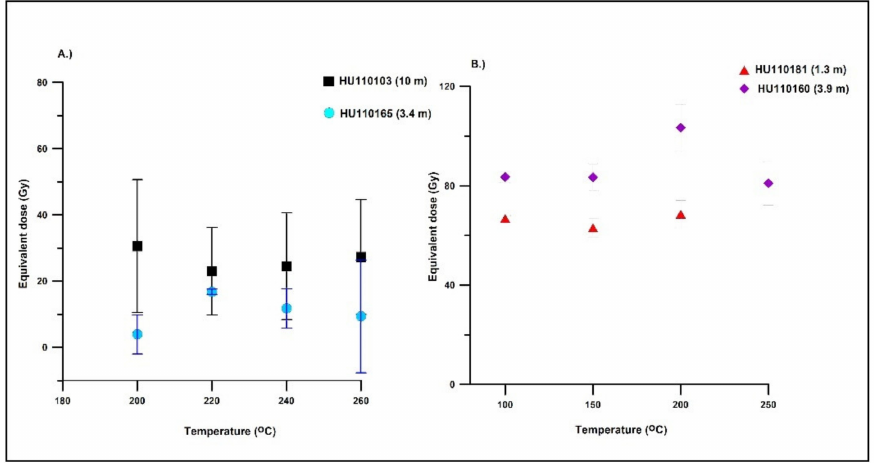
Figure 5. Results of preheat plateau tests for selected quartz ( A ) and feldspar ( B ) samples. The uranium, thorium, and potassium contents range from 1.5 ± 0.05 to 2.8 ± 0.08 ppm, 6.5 ± 0.20 to 10.2 ± 0.31 ppm and 0.94 ± 0.00 to 1.61 ± 0.01 %, respectively (Table S5). The total dose rate for quartz ranges from 2.17 ± 0.11 to 2.90 ± 0.16 Gy ka − 1 (Table 2, Figure S1), which is slightly below the ones for some nearby Serbian sites (3.09 ± 0.18 Gy ka − 1 , 3.22 ± 0.18 Gy ka − 1 [45], but close to the value of some Hungarian sites (Paks: 2.33–2.48 ± 0.10 Gy ka − 1 [46], Sütt˝o: 1.62 + − 0.11 – 2.14 + − 0.15 [47]). The total dose rate for feldspars ranges from 2.13 ± 0.09 to 3.35 ± 0.16 Gy ka − 1 , which is slightly below the values for most samples from the Danube catchment Serbian [30,45,48–50], Romanian [51–53], Austrian [54], Croatian [55–58], and Hungarian samples [15,46,47]. Calculated dose rates for feldspars (mean: 2.78 ± 0.13 Gy ka − 1 ) and quartz (mean: 2.39 ± 0.08 Gy ka − 1 ) follow an upward decreasing trend with minor fluctuations (Figure